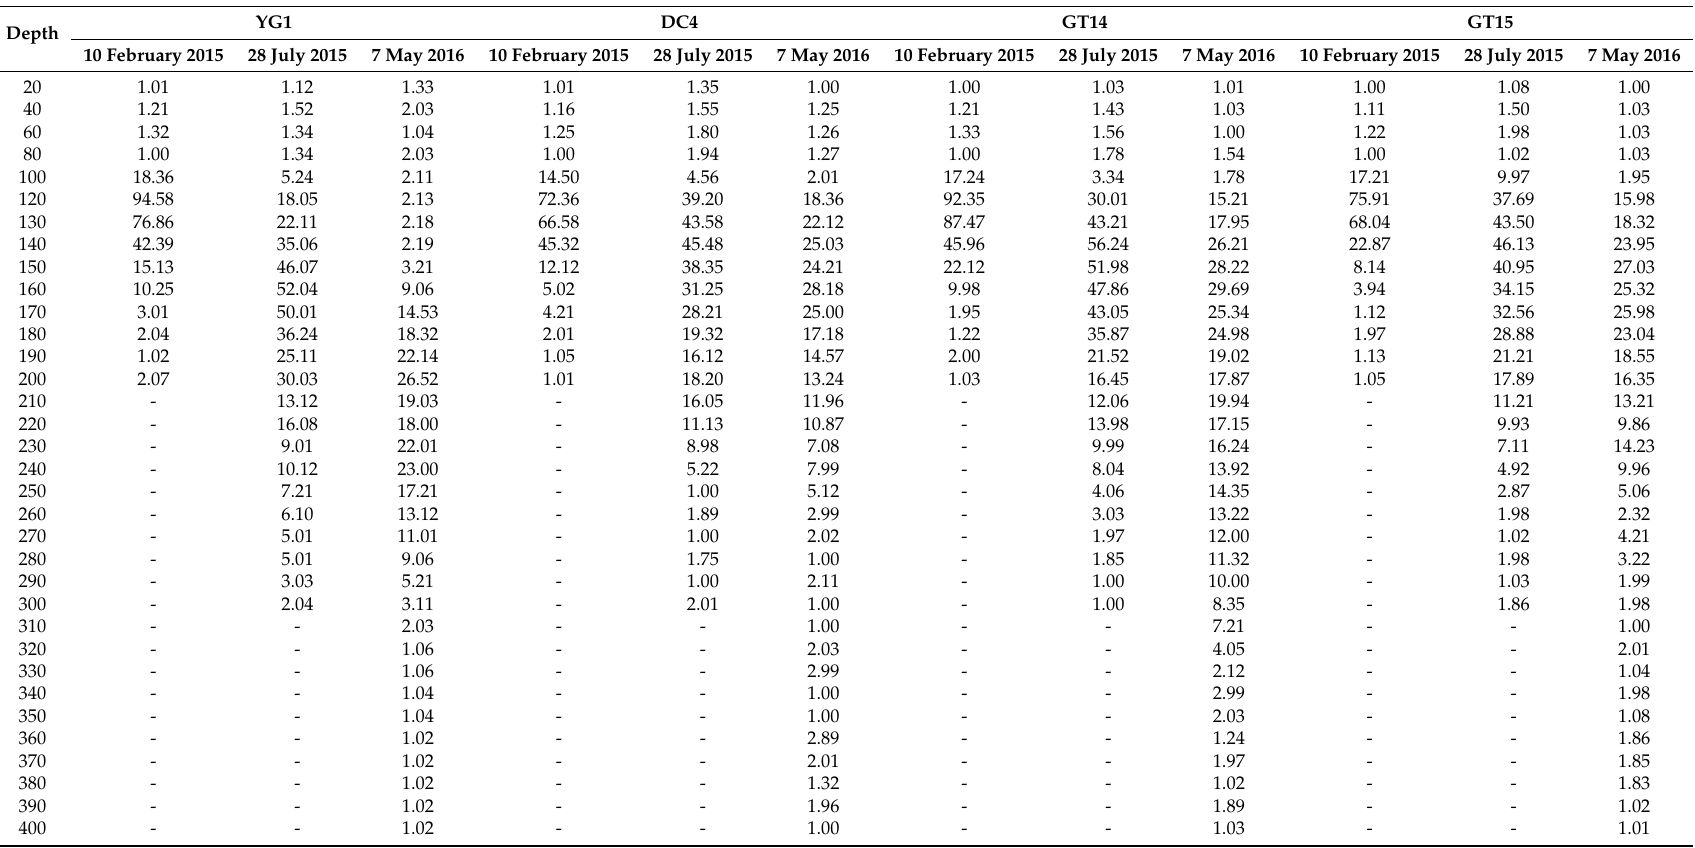
Table 2. Summary of recharge determined by bromide concentration in typical sites unit: